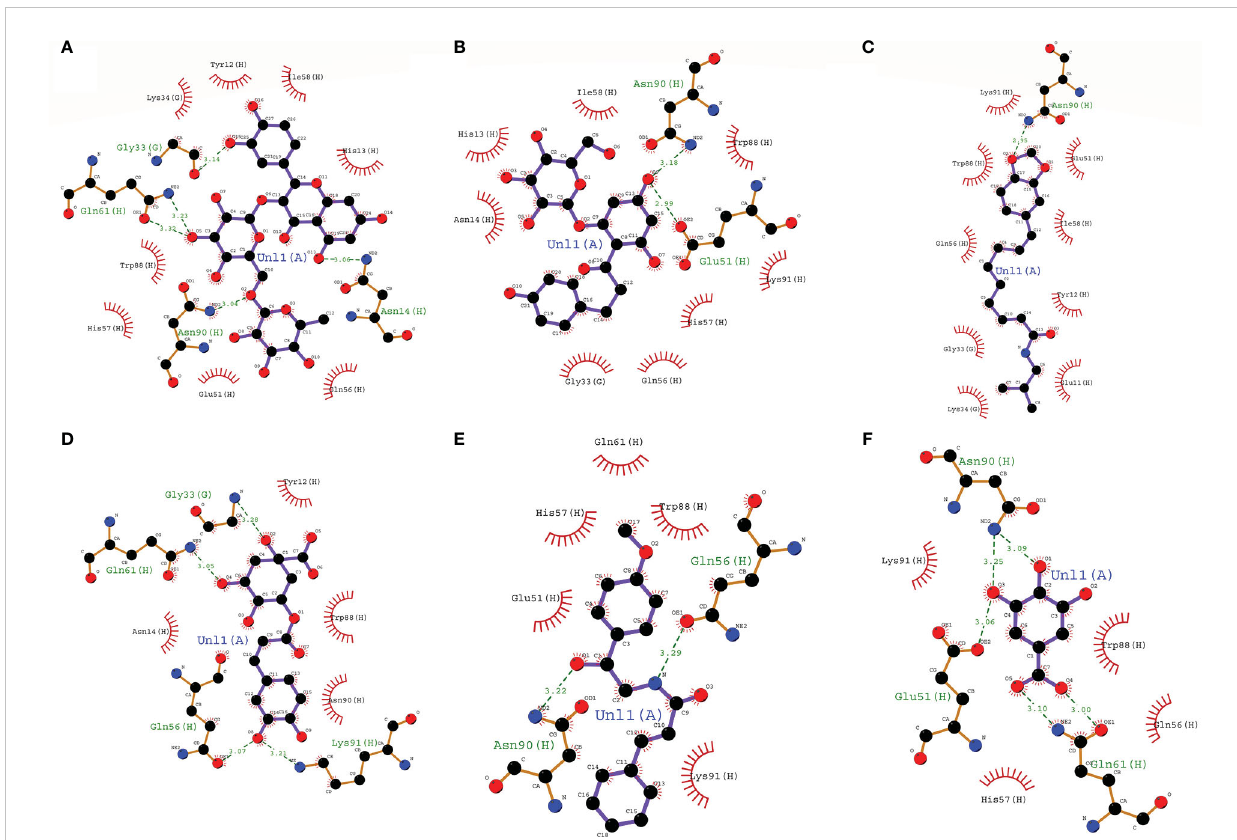
FIGURE 3 The 2D representation of the binding mode and atomic level intermolecular interactions of six selected compounds with 1XTC. (A) CT-RTN, (B) CT- PHD, (C) CT-QRTN), (D) CT-CHL, (E) CT-EA, (F)